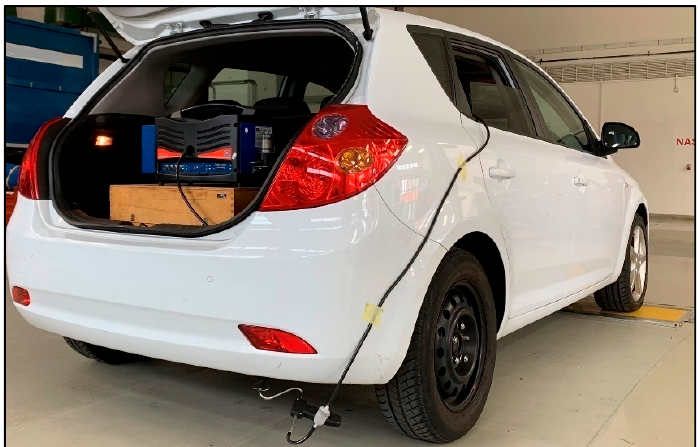
Figure 2. Measuring vehicle before measurement [author].